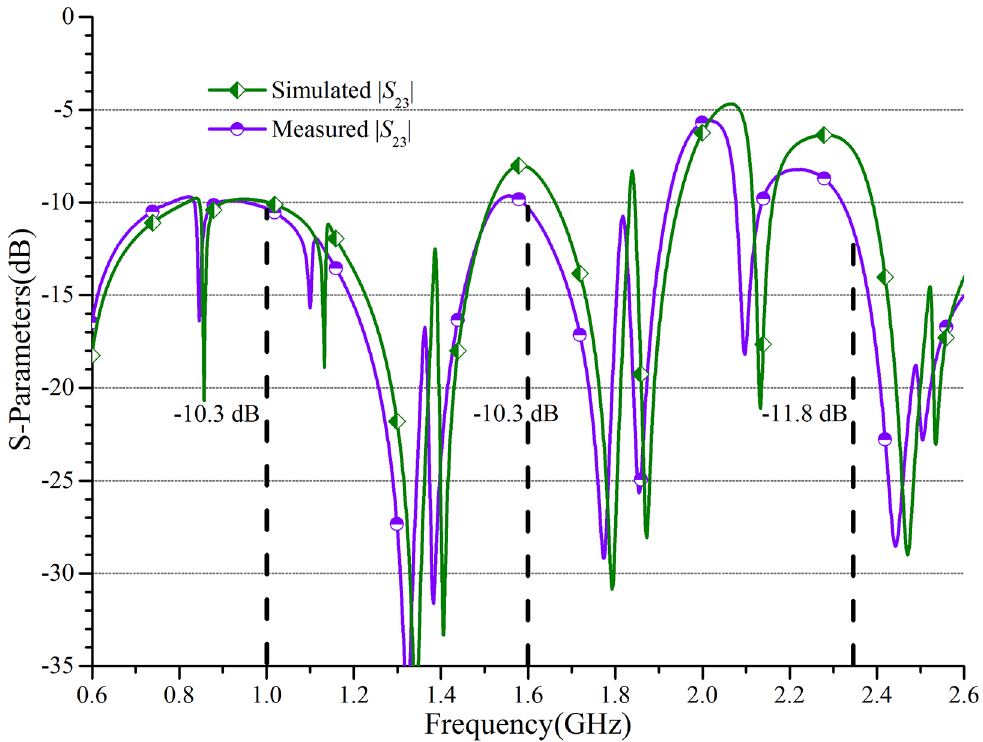
Fig 8. The isolation responses of the TTPD. The simulatedand measuredcoefficient | S 23 | are presented. https://doi.org/10.1371/journal.pone.0178956.g008 isolation resistor. The measured | S | are -10.3 dB, -10.3 dB, and -11.8 dB respectively at 1 23 GHz, 1.6 GHz, and 2.35 GHz. Table 1 compares the proposed TTPD with previous multi-band PDs. It indicates the multi-function design in tri-band operation, impedance transformation, and independent power division ratios of this work.